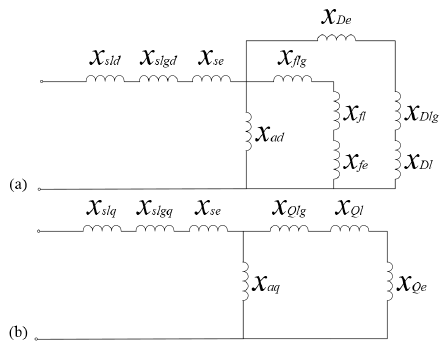
Figure 3. Transient equivalent circuit of an SPSM ( a ) d -axis and ( b ) q -axis.